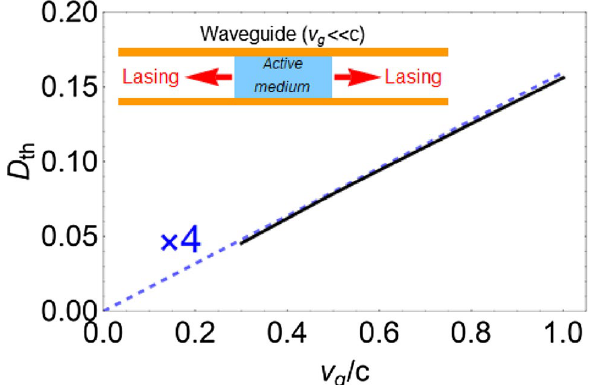
Figure 2. Dependence of the threshold population inversion D th on the group velocity in waveguide. The black solid line is calculated by Eq. (4) for the case of an extended active medium ( l = 8 (cid:31) ). The blue dashed line is calculated by Eq. (5) for the case a subwavelength active medium. Inset: sketch of laser based on waveguide with low group